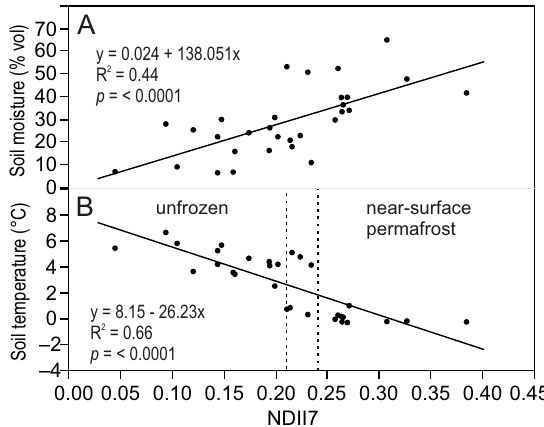
Figure 7. Relationships between NDII7 (Landsat 8 OLI) and ( A ) soil moisture (upper 20 cm); and ( B ) soil temperature (1 m) at field sites ( n = 30). Vertical dashed lines represent cut-points used to delineate unfrozen from near-surface permafrost classes in mapping. All sites with NDII7 values < 0.21 had soil temperature ≥ 2.5 are were likely permafrost-free, whereas most sites with NDII7 values > 0.24 had soil temperatures near or below freezing, suggesting the presence of near-surface permafrost.